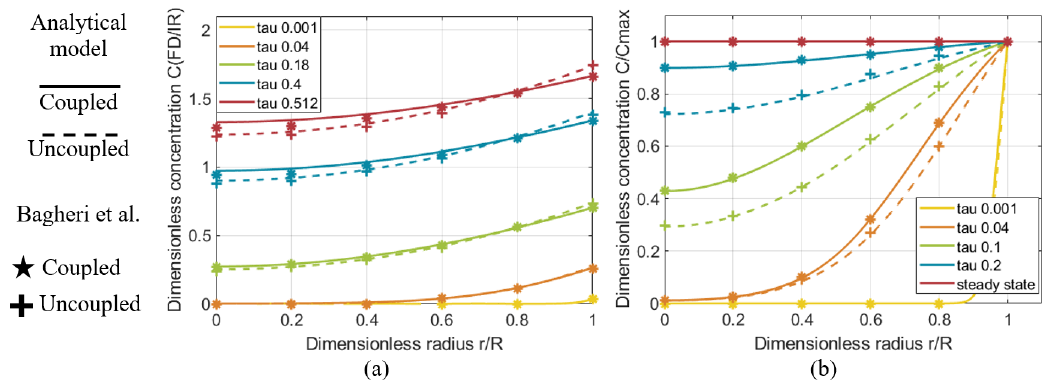
Figure 3. Concentration level as a function of dimensionless radial position for different time constants τ in galvanostatic ( a ) and potentiostatic ( b ) insertion. The analytical model is reported with solid (coupled) and dashed (uncoupled) lines. The solution of the numerical model [26] is reported in discrete radial coordinates with dots (coupled) and crosses